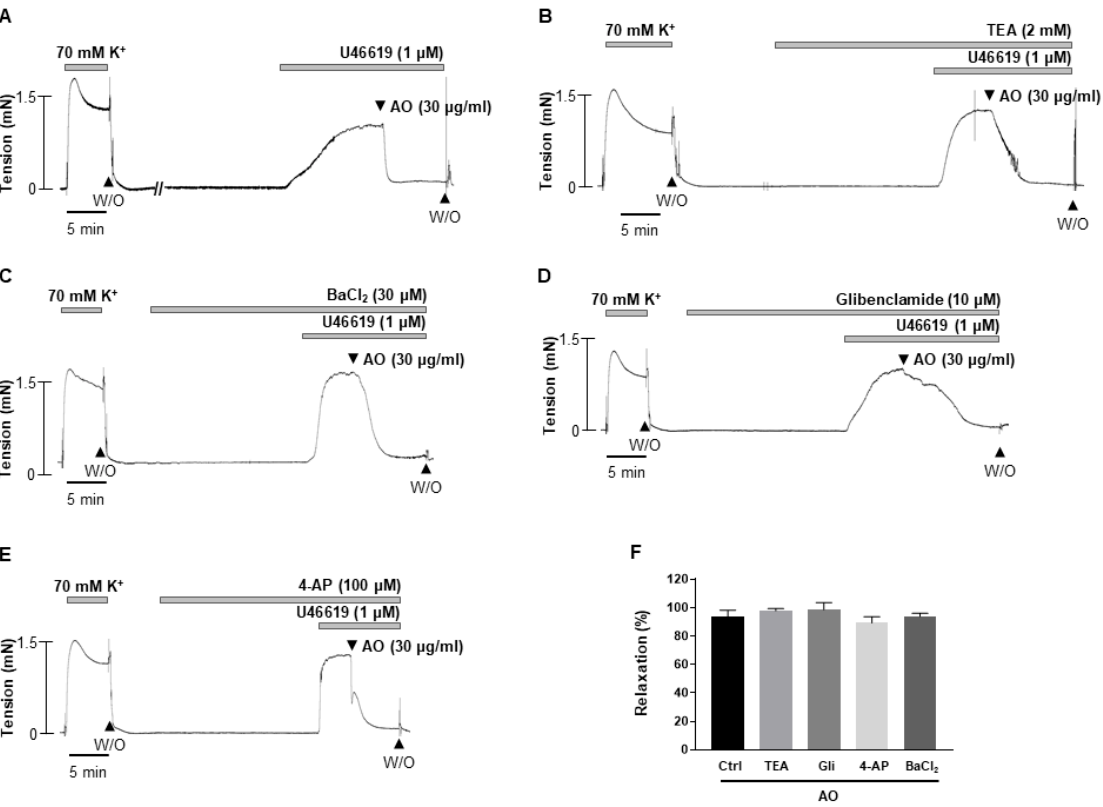
Figure 3. Effect of K + channel blockers on A. officinarum extract-induced vasodilation. ( A ), effect of A. officinarum extract in the mesenteric artery pre-contracted with U46619 (1 µ Μ ). ( B – E ), effect of A. officinarum extract in the presence of TEA ( B ), or BaCl 2 ( C ), or glibenclamide ( D ), or 4-AP ( E ). ( F ), statistical analysis of the relaxation response of A. officinarum extract in the presence of various K + blockers. Relaxation of arteries is expressed as the percentage of the contraction induced by U46619 (1 µ Μ ). Mean ± SD (n = 5). (AO: Alpinia officinarum extract; TEA: tetraethylammonium; Gli: glibenclamide; 4-aminopyridine: 4-AP).